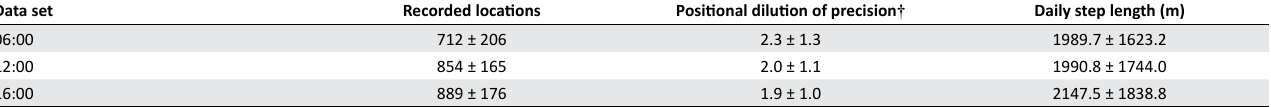
TABLE 2-A2: Descriptive statistics of daily elephant location data recorded in the morning (06:00), midday (12:00) and afternoon (16:00). For each parameter, the mean ± s.d. is reported for the six female elephants occupying the Main Camp – Colchester section of Addo Elephant National Park, South Africa. Data set